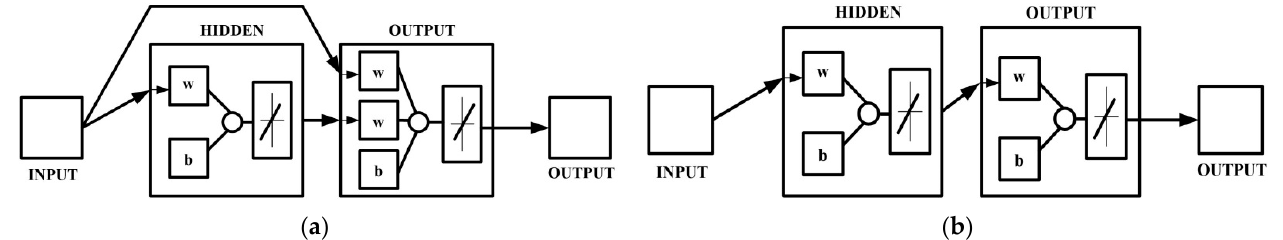
Figure 5. Artificial neural network design based on ( a ) cascaded forward backdrop and ( b ) feed-forward backdrop based design.